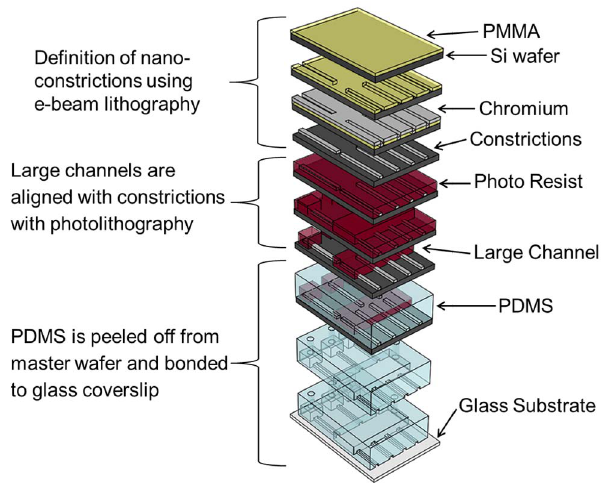
Figure 2. Schematic depicting the device fabrication process. 1) PMMA is spun on a 3-inch silicon wafer. 2) The constriction design is written with electron beam lithography and developed. 3) Chromium is sputtered (the height of the constrictions is determined by this step). 4) Metal lift-off is done to complete the constriction. 5) Positive photoresist is spun on the wafer. 6) Large features are aligned with the constrictions and exposed using photo-lithography. 7) Large features are developed, completing the master wafer. 8) PDMS is poured over the master and heat cured. 9) PDMS is peeled off and access holes are drilled. 10) The PDMS is bonded to a glass cover slip using oxygen plasma to complete the device.